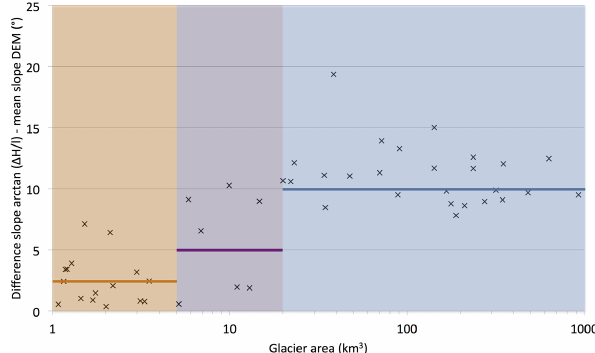
Figure 2. Differences between α L (mean slope from arctan ( (cid:49)H / l )) and α DEM (mean slope from DEM) for selected test glaciers, in- cluding the linear regression lines that are used as correction fac- tors for glaciers > 20km 2 (blue), glaciers between 5 and 20km 2 (purple) and glaciers < 5km 2 (orange). Glaciers were randomly se- lected, but the 20 largest glaciers of the inventory are included (note the logarithmic scale of the x